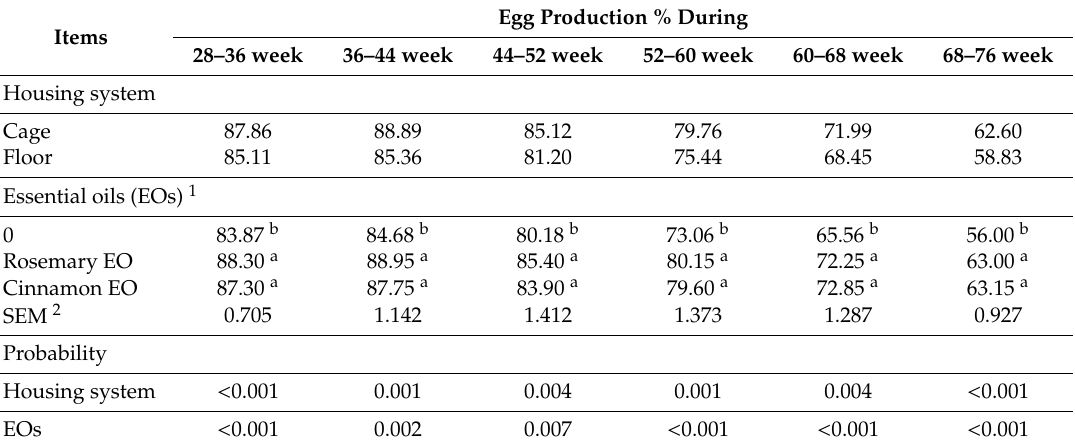
Table 2. Egg production of laying hens as a ff ected by di ff erent housing systems, essential oils and their interaction during the